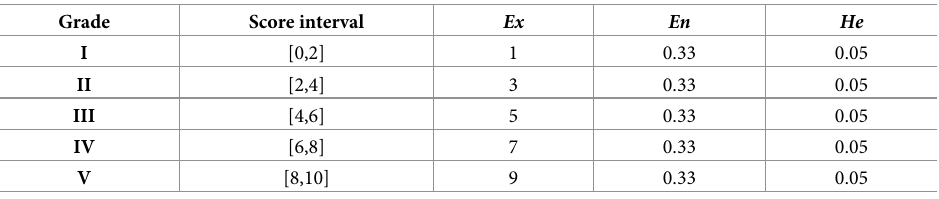
The first column indicates the comfort level. The second column indicates the score interval corresponding to the comfort level. The rightmost three columns contain the three parameters corresponding to different standard